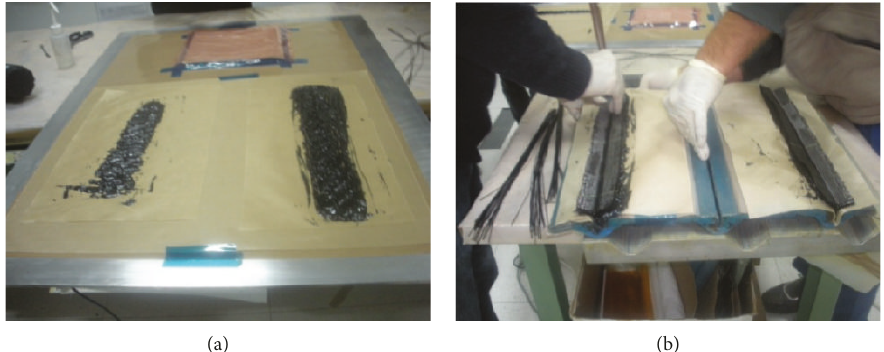
Figure 11: (a) Film resin for the T stringer and (b) deposition of the impregnated T stringer.